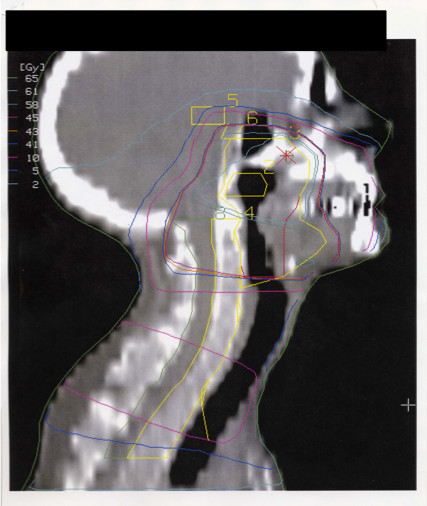
The sagittal view of the dose distribution of the external beam of patients with cancer of the epipharynx. Volumes of interest and isodose lines are presented. Abbreviations: 2= Gross target volume (GTV), 3=Planning target volume (PTV) 4=medulla, 5= pituitary, 6= hypothalamus.